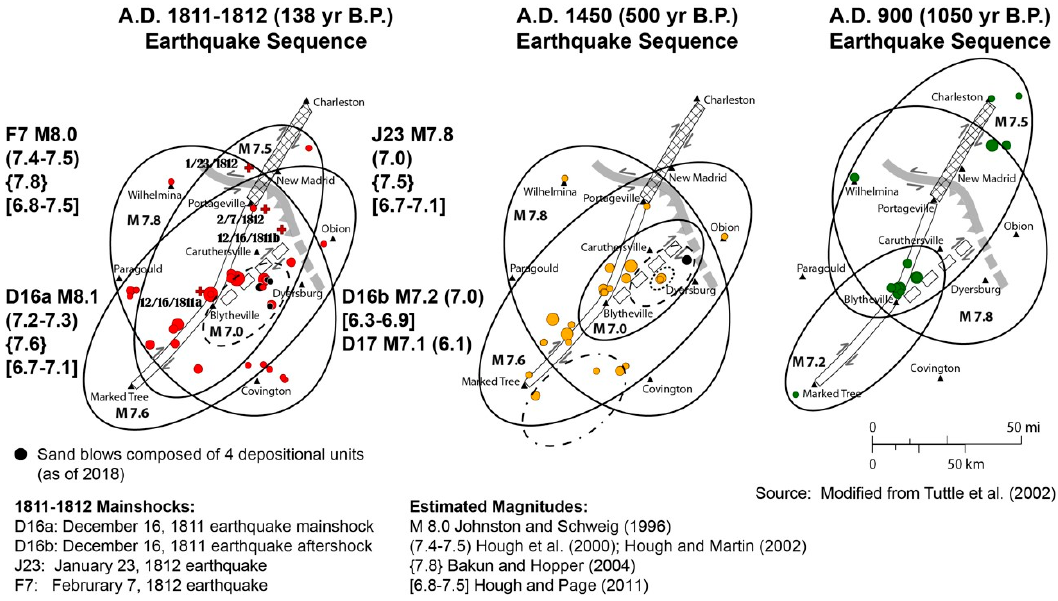
Figure 30. Liquefaction fields for the past three New Madrid earthquake sequences as interpreted from spatial distribution and stratigraphy of sand blows (modified from Reference [6]). The colored circles represent sand blows that formed during the AD 1811–1812 (red), AD 1450 (orange), and AD 900 (green) sequences. Black circles indicate sand blows composed of four depositional units. Sand blows are shown relative to the preferred fault rupture scenario for the AD 1811–1812 earthquake sequence (from Reference [211]). Earthquake magnitudes shown within 1811–1812 ellipses are from Reference [203]. Other magnitude estimates are from References [208,218,219].